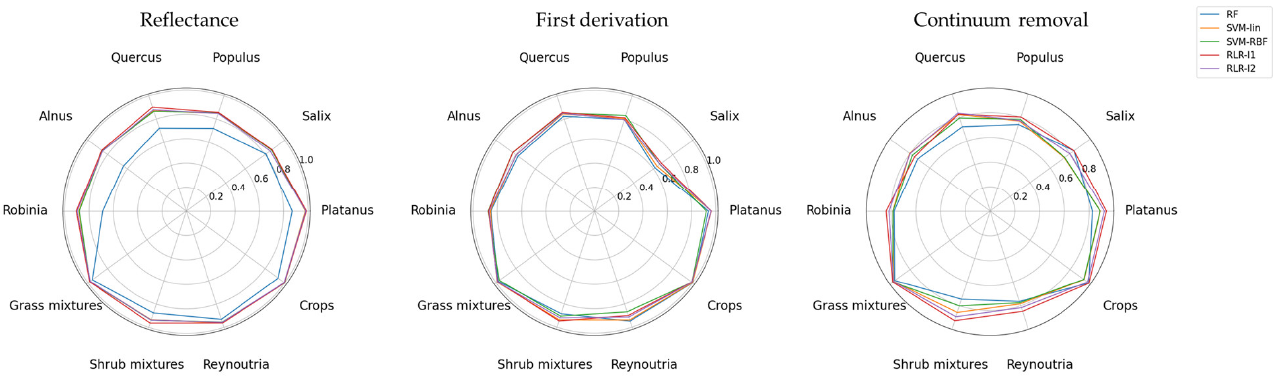
Figure 7. Average F1-scores obtained with reflectance spectra, first derivation, and continuum removal.